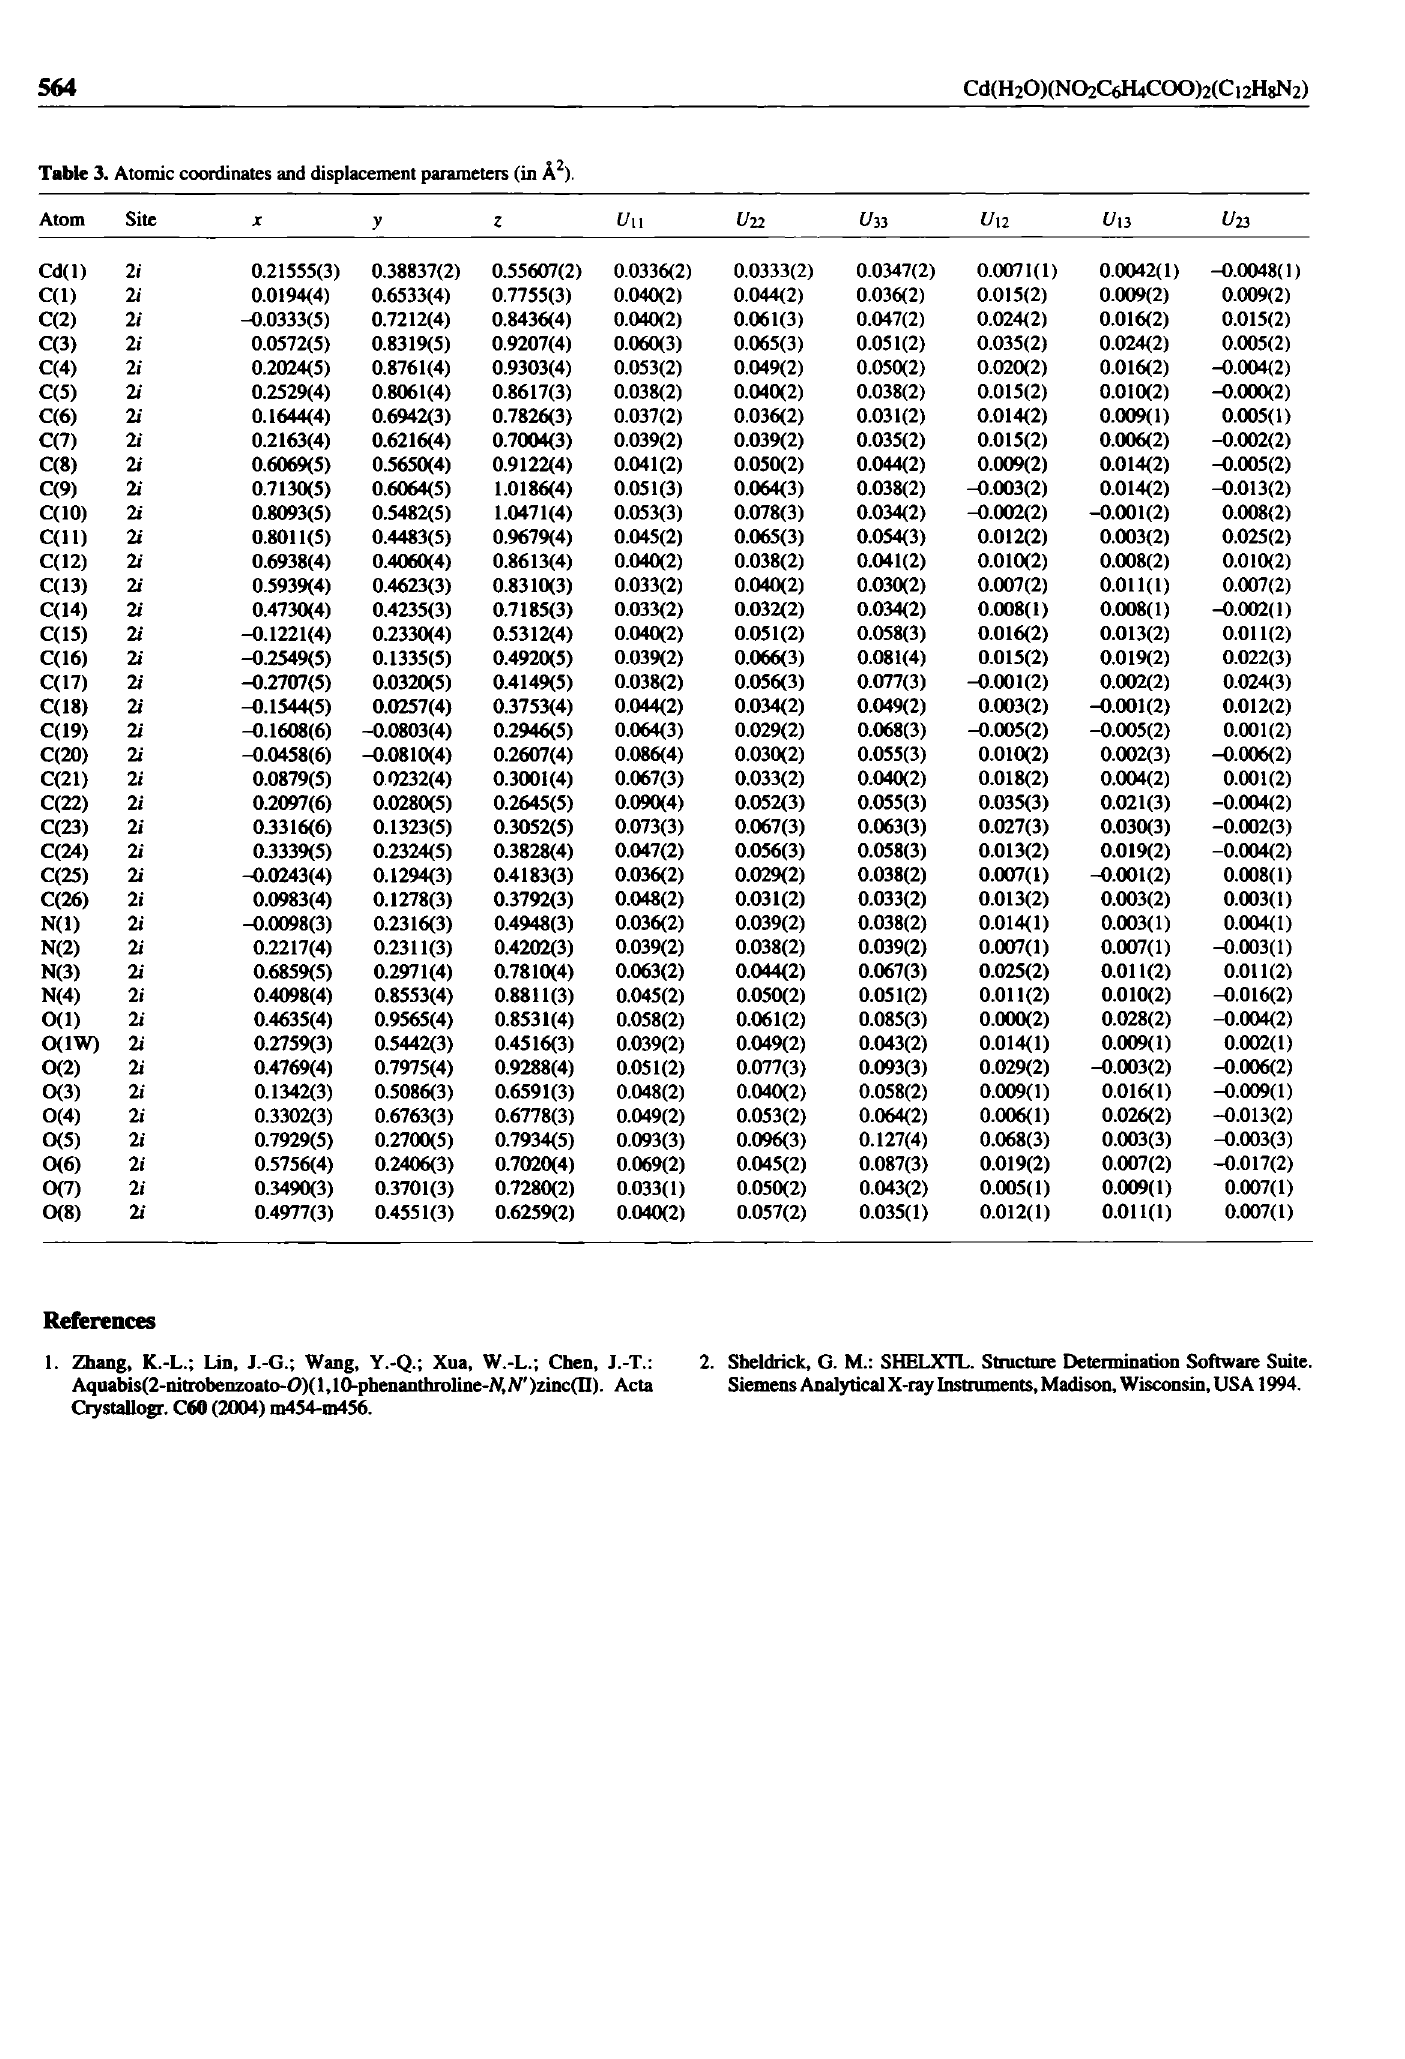
Table 3. Atomic coordinates and displacement parameters (in Ä 2